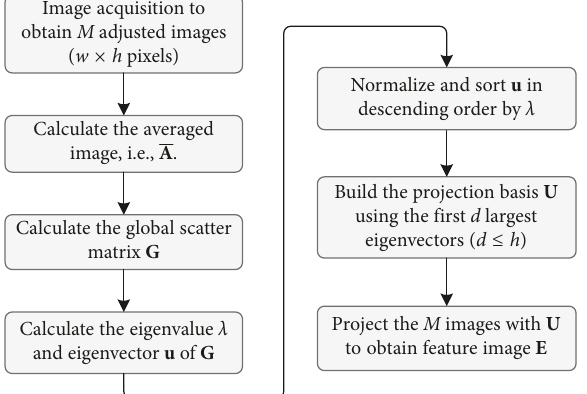
Figure 2: Flowchart of feature processing with